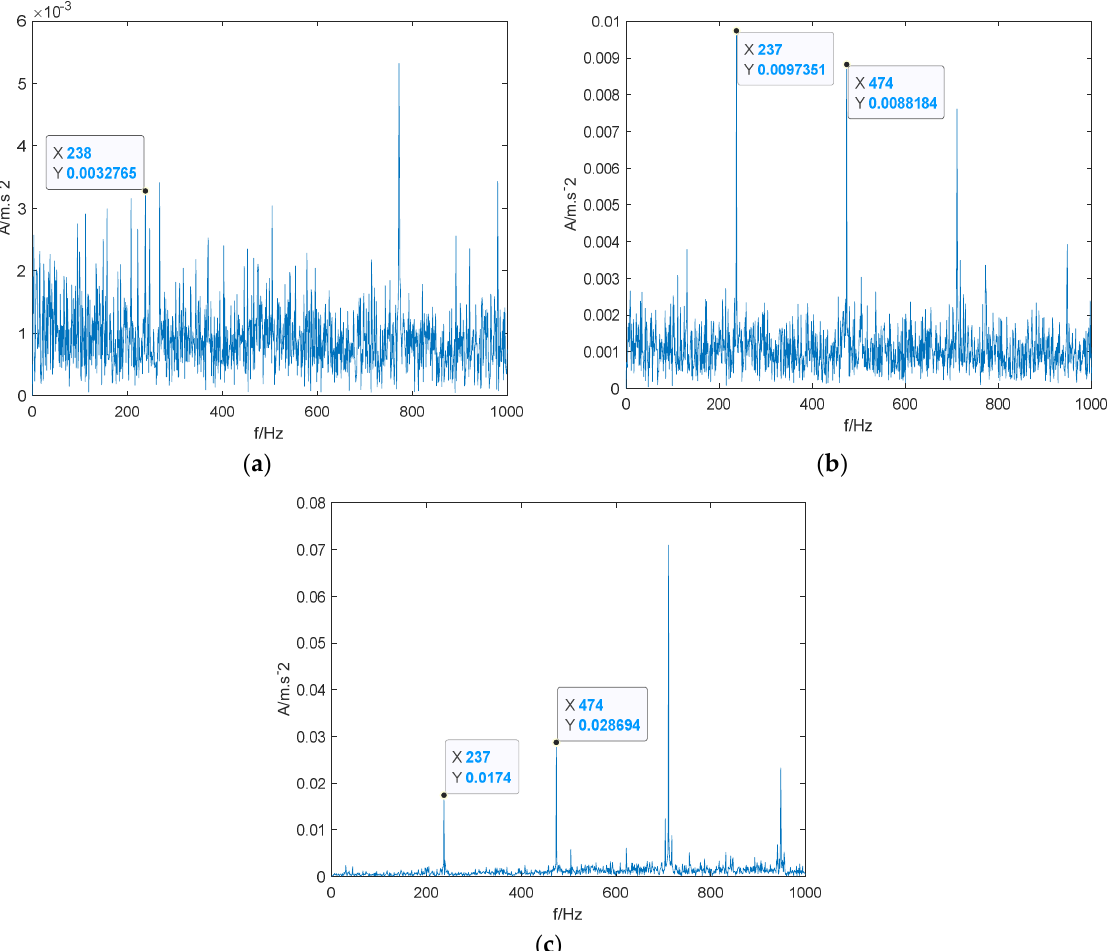
Figure 22. Bearing 3 degradation index based on LLE and SVDD.